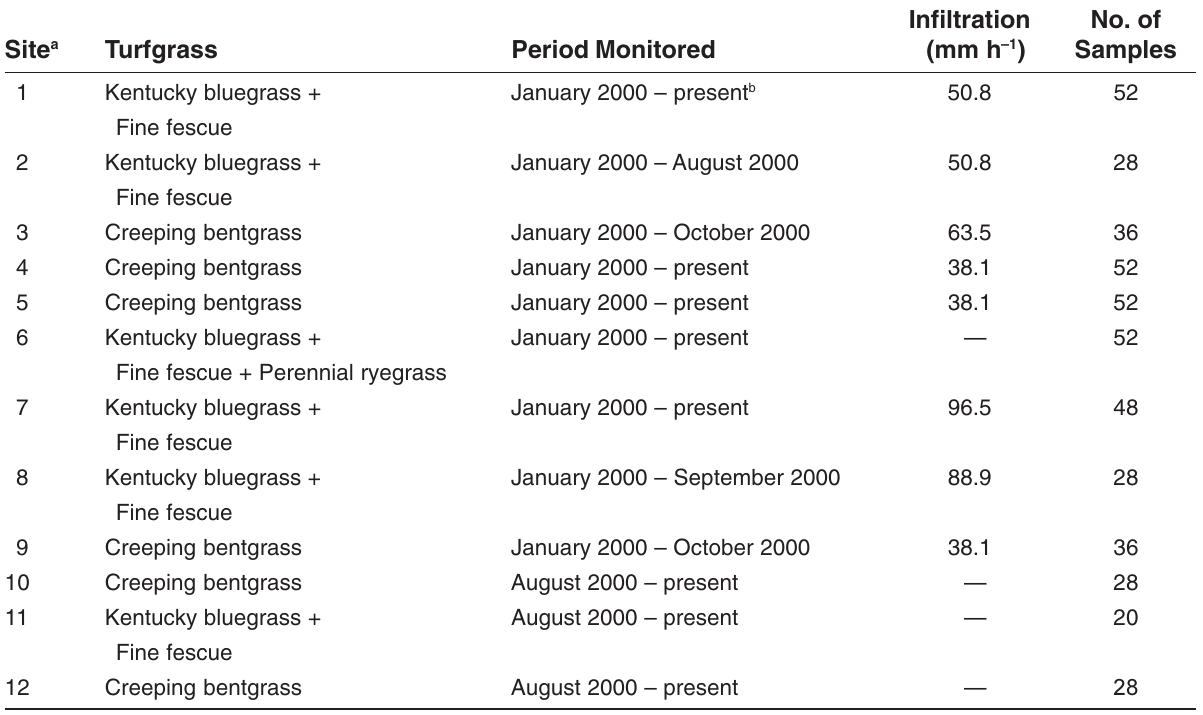
Turfgrass Species, Period Monitored, Soil Infiltration Rate, and Sample Number Taken from 12 Monitoring Sites in Southern Rhode Island